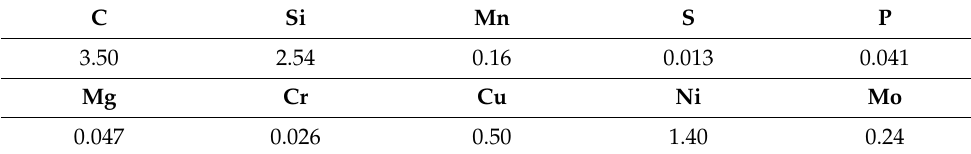
Table 1. Chemical composition of ductile iron (mass%),